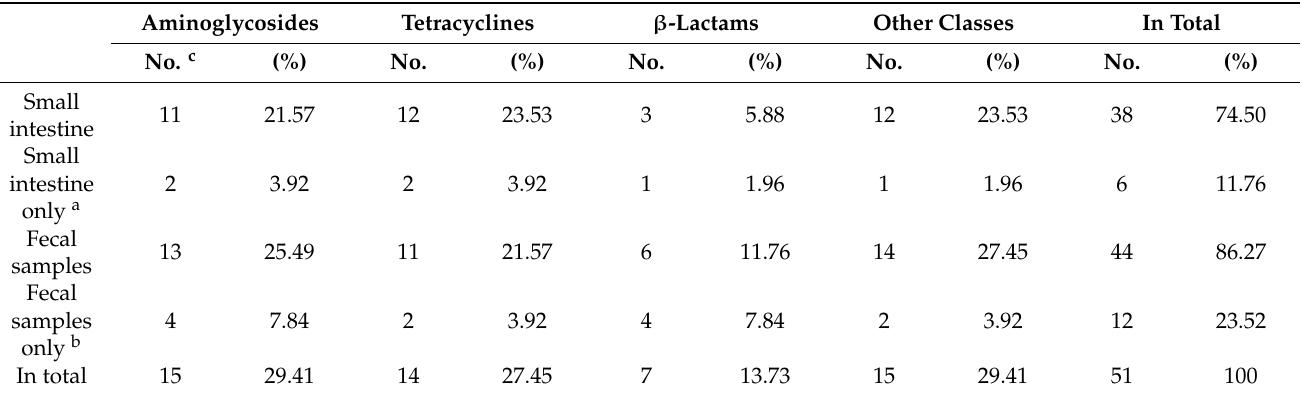
Table 2. The number and proportion (%) of ARG types of different antibiotic classes detected in swine small intestinal and fecal